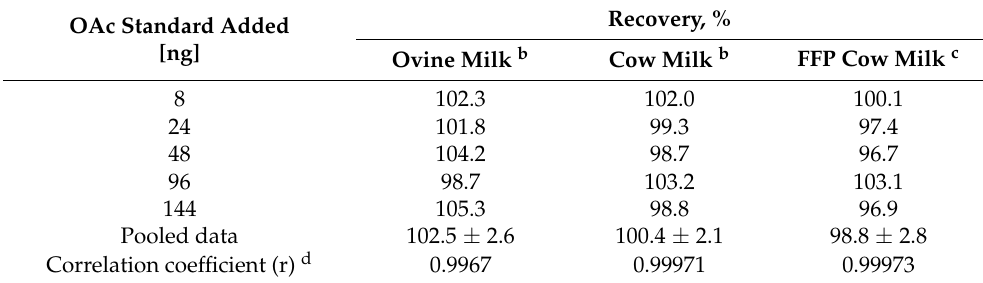
Table 5. Recoveries (R, %) a of OAc standards added to milk of sheep and cows and FFP cow